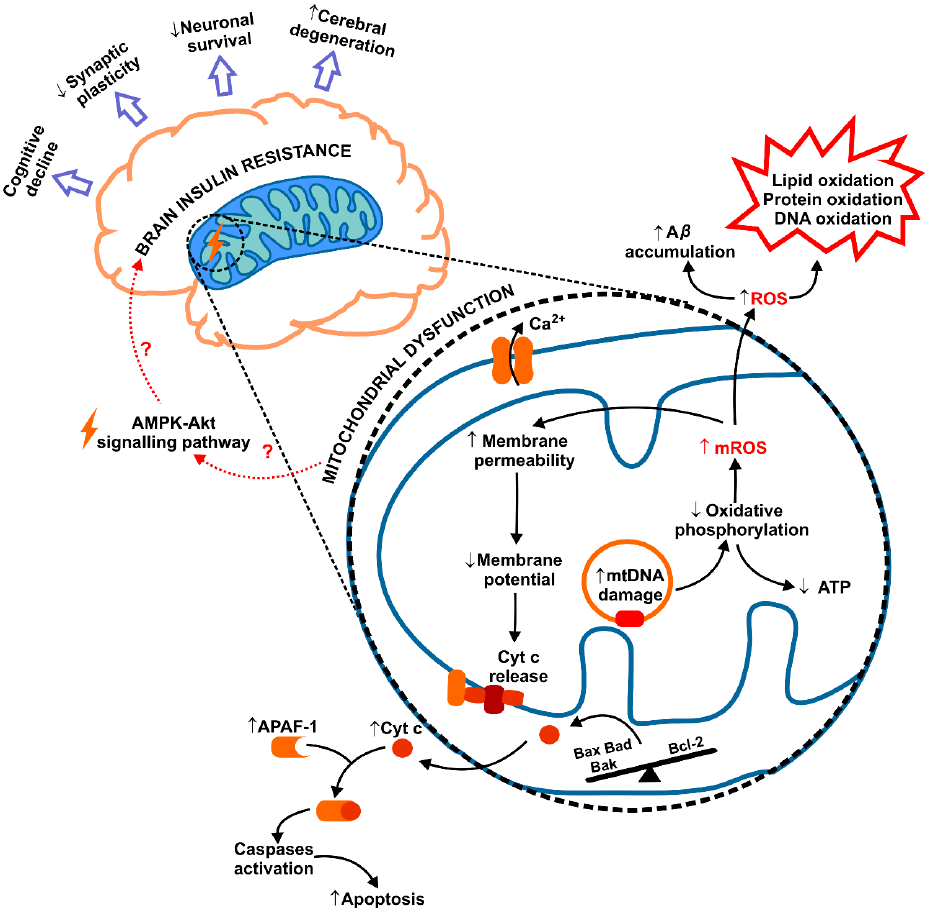
Figure 4. Mitochondrial dysfunction in brain insulin resistance. The results of recent studies indicate the role of mitochondrial abnormalities in the brain IR. Increased production of mitochondrial ROS (mROS), cytochrome c release, as well as functional and ultrastructural changes of mitochondria have been confirmed in IR brain. Interestingly, brain mitochondrial dysfunction and A β accumulation may be responsible for disturbances in apoptosis, synaptic plasticity, cognitive decline, and cerebral degeneration in IR patients. Abbreviations: A β , amyloid β -peptides; APAF1, apoptotic protease activating factor 1; BAD, Bcl-2-associated death promoter; BAK, Bcl-2 homologous antagonist killer; BAX, Bcl-2-associated X protein; cyt c, cytochrome c; mROS, mitochondrial ROS; mtDNA, mitochondrial DNA; ROS, reactive oxygen species.